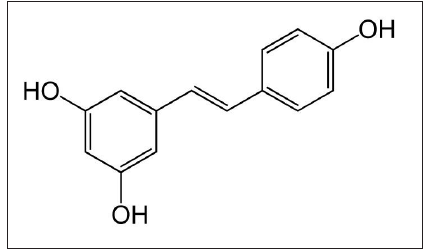
Figure 1. Chemical structure of resveratrol